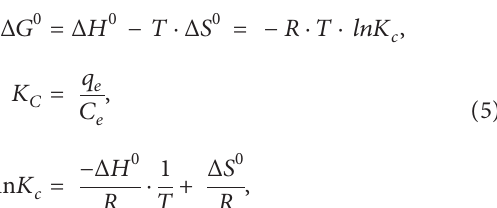
Figure 3: (a) ln( A t – A e ) vs. t plot and (b) t / q vs. t plot to calculate the rate constant. Experimental conditions: m adsorbent pH � 7, and C o � 20mg · L − 1